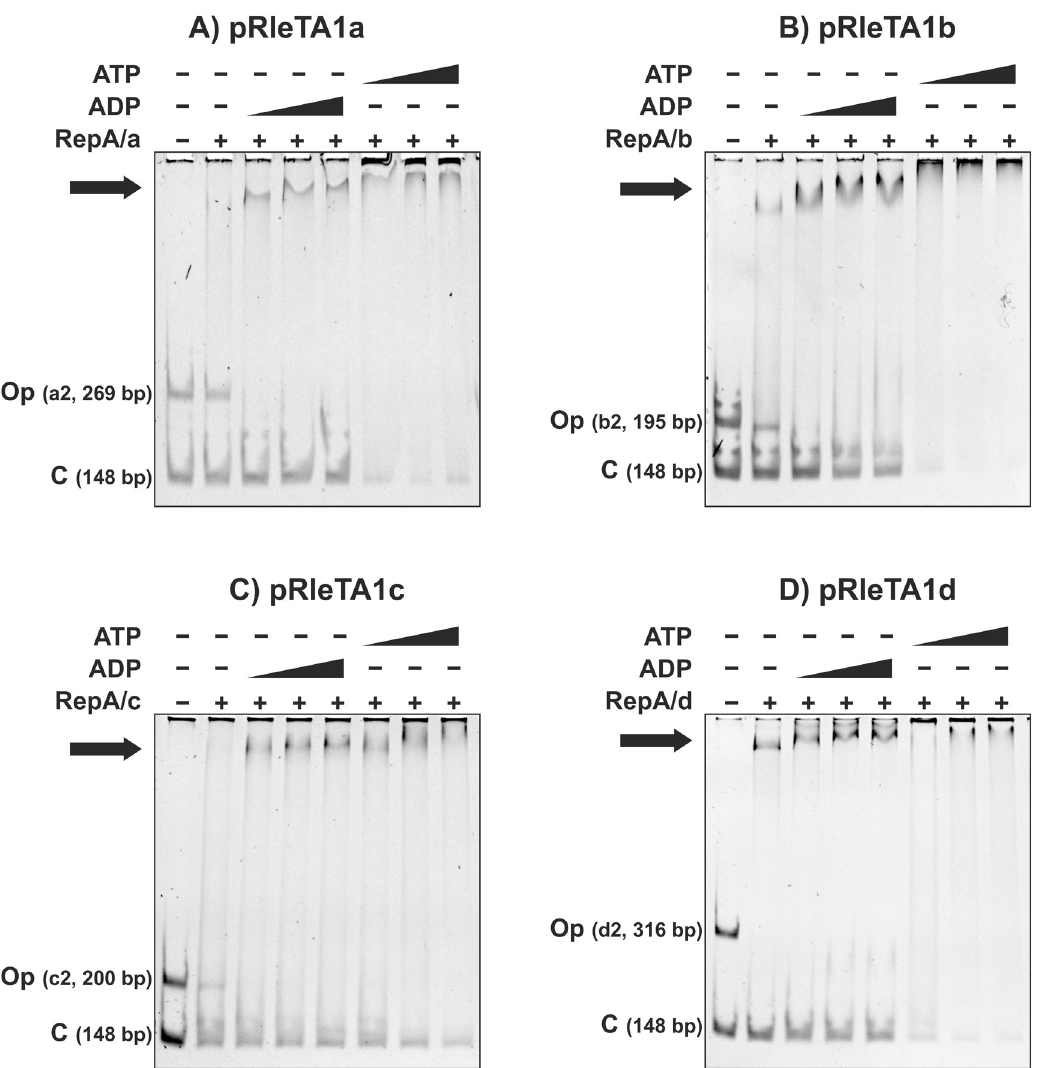
Fig 5. Analysis of ADP/ATP role in the DNA binding specificity of RepA proteins: (A) pRleTA1a, (B) pRleTA1b, (C) pRleTA1c, and (D) pRleTA1d. 'Op' indicates DNA fragment (15 ng) comprising mapped operator sequences of individual repABC operons, while 'C' means non-specific DNA competitor (15 ng) (148 bp DNA fragment of the gene coding for Km r of the pBBR1MCS-2). The Op fragments (a2, b2, c2, d2) correspond to the ones shown in Fig 2. Black triangles indicate the increasing concentration of ADT/ATP (0.1, 1, and 2 mM) while '+' means presence of respective His 6 -RepA (10 pmol) protein in the binding reaction. Black arrows indicate the position of the retarded DNA